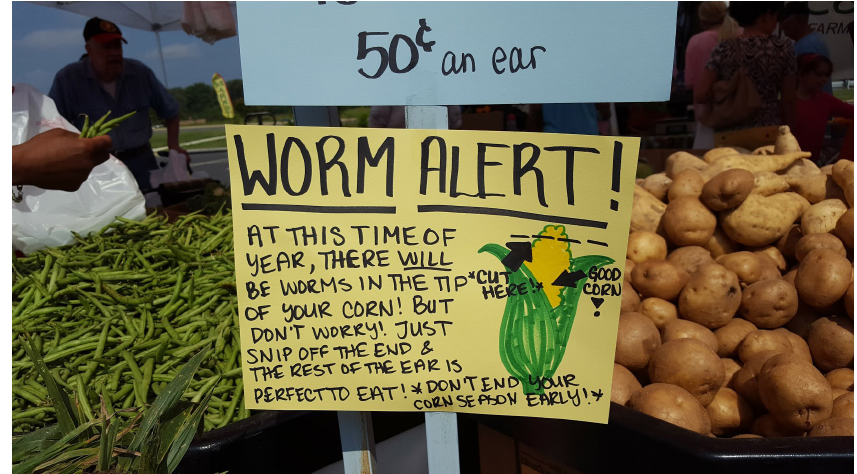
Figure 4 . Sign informing customers of worms in ears of corn at the Spotsylvania County Farmers Market, 2016. Photo by